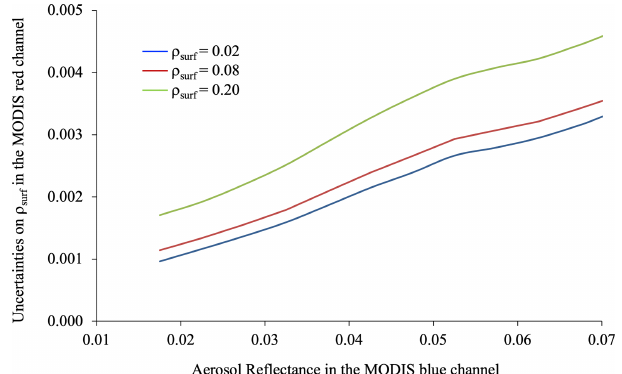
Figure 15. Uncertainties in ρ surf in the MODIS red channel versus the aerosol reflectance in the MODIS blue